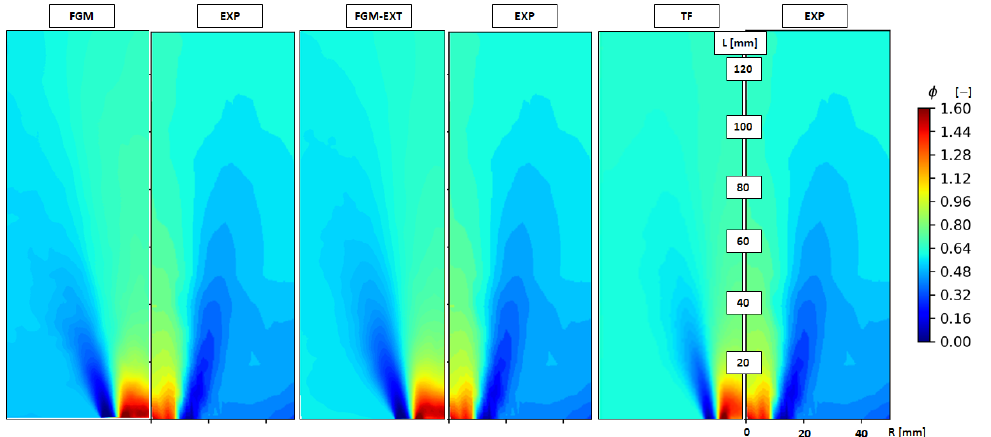
Figure 7. Contour maps of equivalence ratio up to 130 mm from FGM, FGM-EXT, and TF (from left to right ) simulations compared with experimental data from [7].